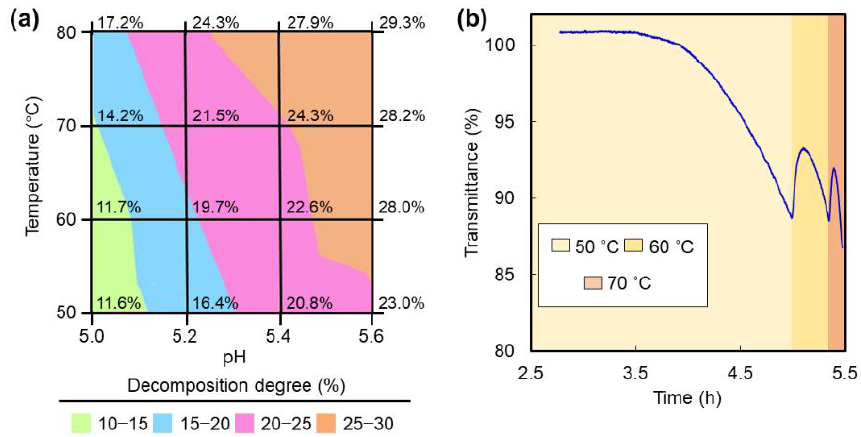
Figure 3. Matrix of the cleavage degree of PAA-Pht ( a ) and transmittance change of PAA-Pht aqueous solution against a stepwise change of temperature ( b ). In ( b ), polymer concentration: 4.0 mg/mL, pH: 5.2.